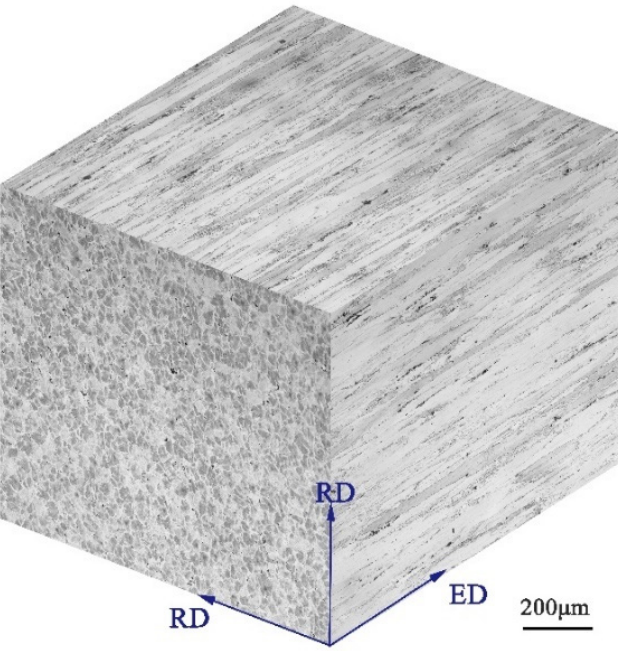
Figure 2. Three-dimensional optical micrograph of the extruded 7075 Al alloy. Figure 3a,b is OM and SEM of the second phase, respectively. The composition of these second phases was identified by an energy dispersive spectrometer (EDS) and the results are shown in Figure 3c. The ratio of Al to Cu is close to 2:1, so it can be considered as Al 2 Cu. The second phases of Al 2 Cu can hinder dislocation movement, which is an important reason for the increase in the static mechanical properties [20,21].